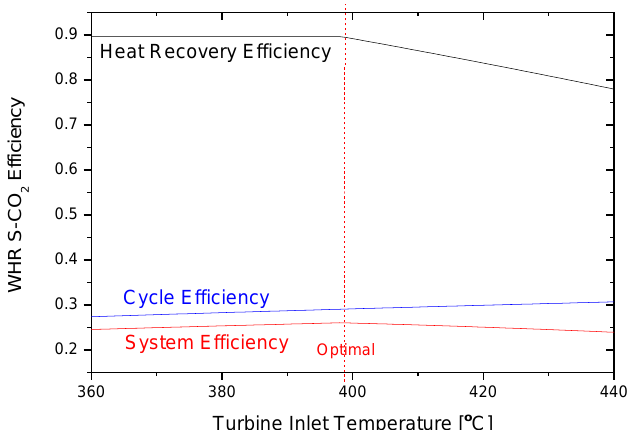
Figure 2. Optimization of turbine inlet temperature for maximum system efficiency of split S-CO 2 power cycle.